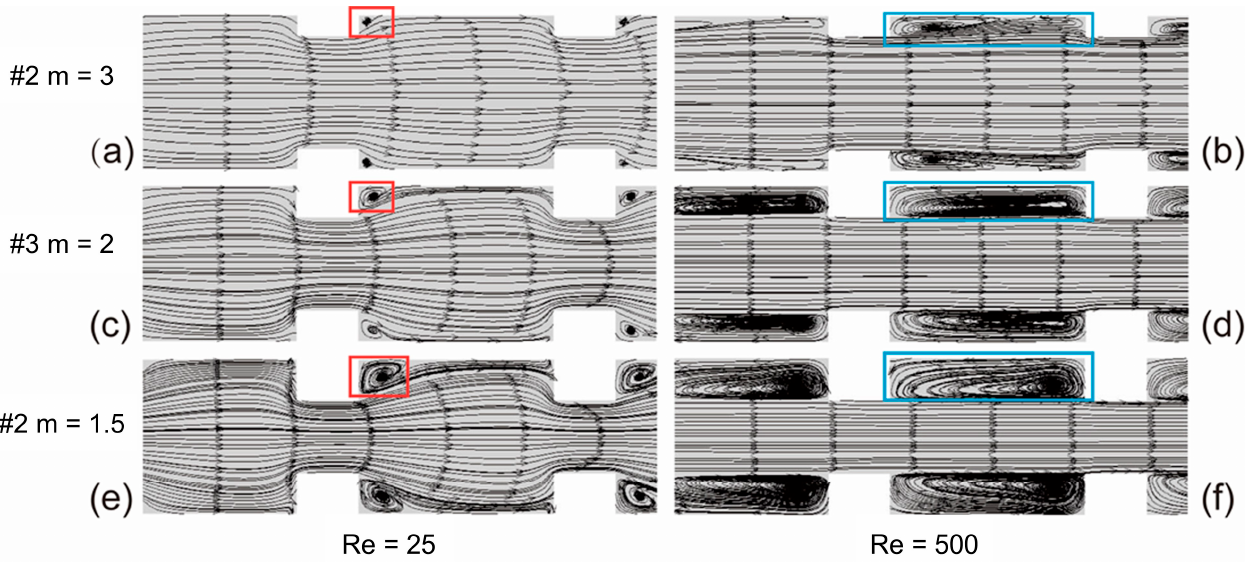
Figure 4. Streamlines in the transverse central section of the fluid with different fin aspect ratios: ( a ) m = 3, Re = 25; ( b ) m = 3, Re = 500; ( c ) m = 2, Re = 25; ( d ) m = 2, Re = 500; ( e ) m = 1.5, Re = 25; ( f ) m = 1.5, Re = 500. The red box indicates the stagnation vortices formed at the trailing edge of the fins at Re = 25, and the blue box indicates the impact vortices formed in the intervals between fins at Re = 500.